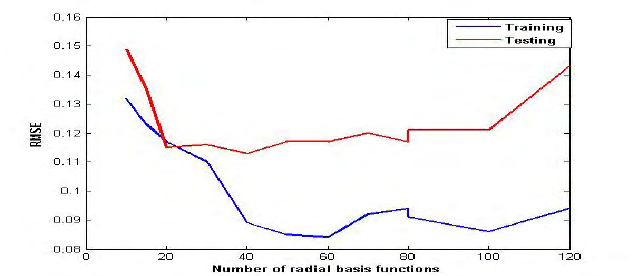
Fig. 7. The effect of cluster number - sunspot